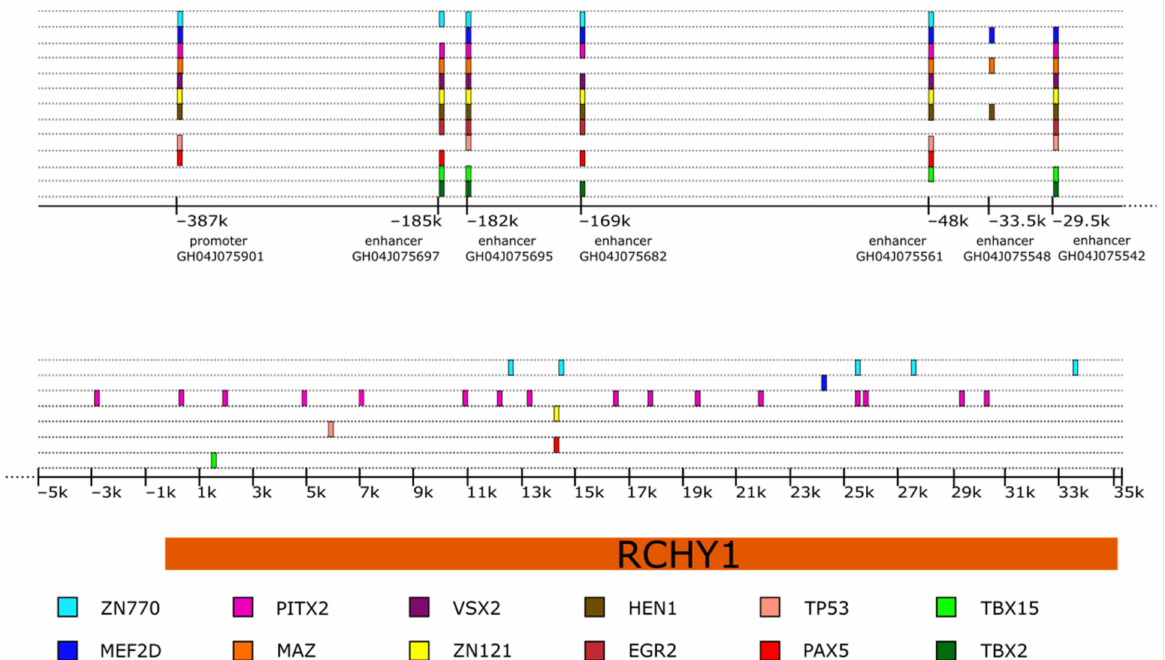
Figure 2. The scheme of potential binding sites of transcription factors in the Pirh2-coding gene and its regulatory elements. k—1000 base pairs relative to the transcription start